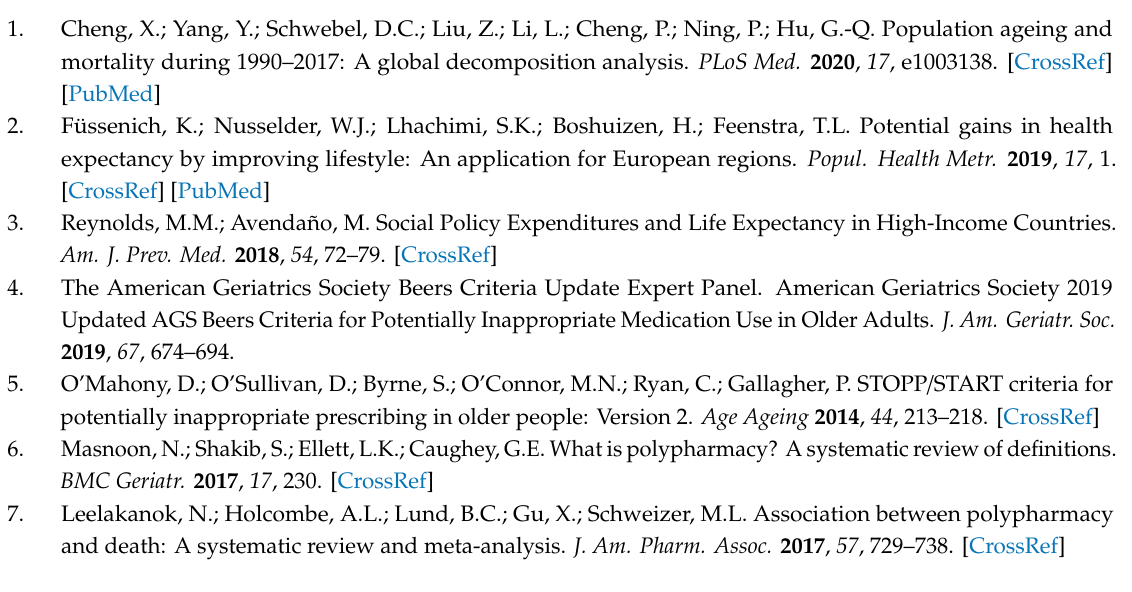
Table S1: Genetic influences on e ffl ux pumps and organic anion-transporting polypeptides29, Table S2: Frequently prescribed medications with known P450 metabolism which are neither PIMs nor PPOs, Table S3: Foods and lifestyle drugs with known P450 metabolism which are neither PIMs nor